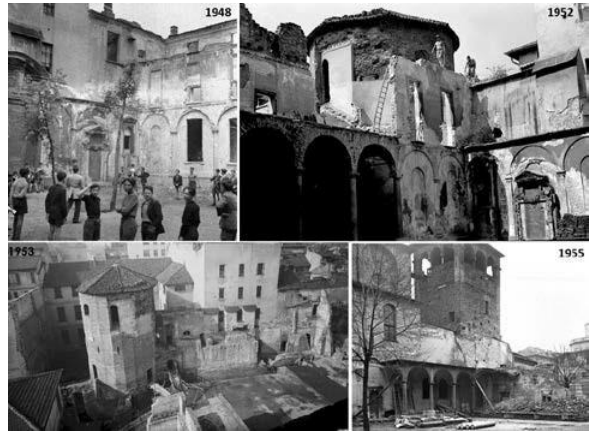
Figure 3. The transformations of cloister of the Monastery of St. Maurizio in the years following the Second World